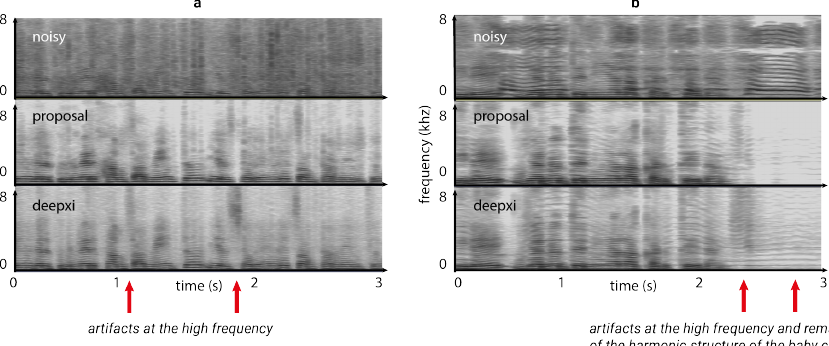
Figure 4. Spectrograms of two audio examples. ( a ) Speech with noise from a call center (SNR = 5 dB), ( b ) speech with noise of baby crying (SNR = 5